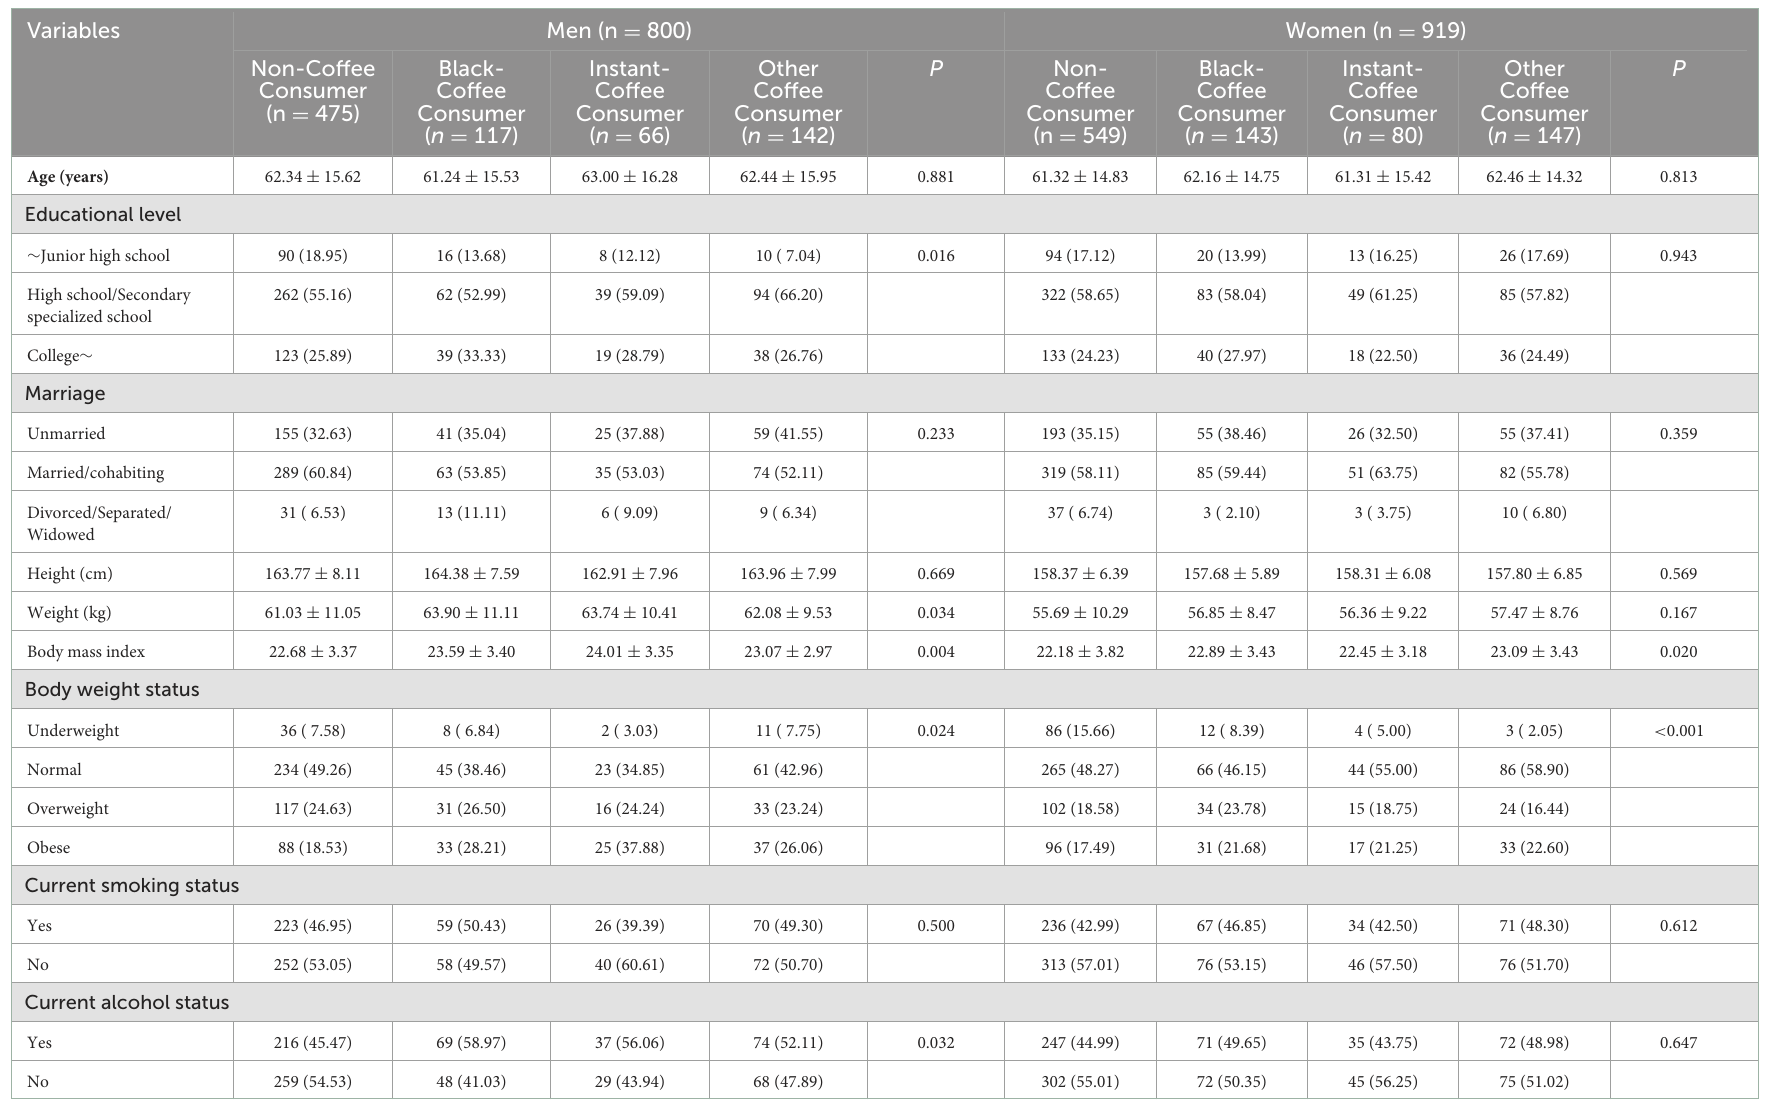
TABLE 1 General characteristics of the cross-sectional study population according to coffee consumption pattern by gender.